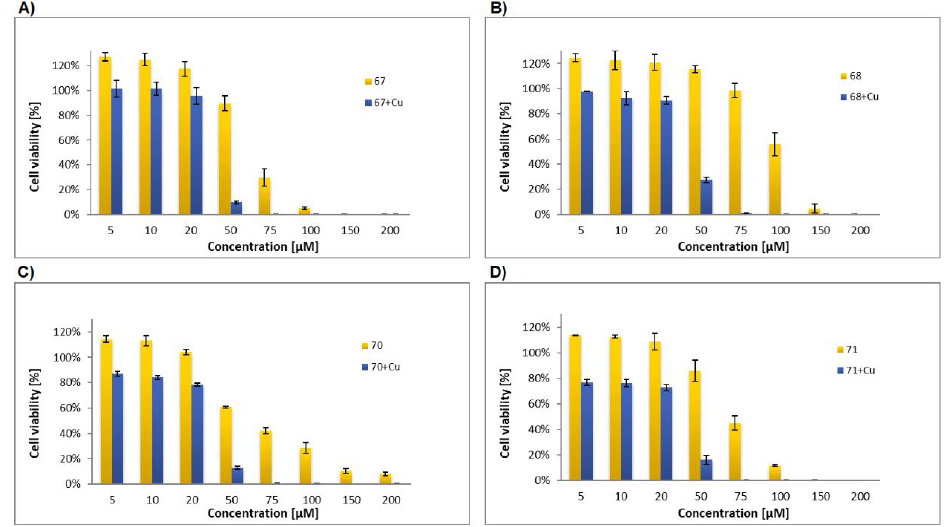
Figure 5. The dependence of MCF-7 cell proliferation on the concentration of the potential inhibitorin the absence and presence of Cu 2+ .